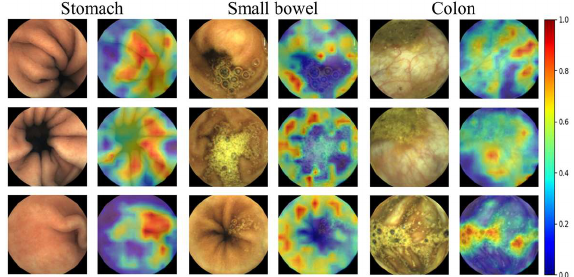
Figure 3. Relevance-CAM results from three organs. (WCE images taken by MiroCam MC1200 and processed by MiroView 4.0—http://www.intromedic.com/eng/main, accessed on 31st, July, 2022). The jet color maps show class activation maps in which the reddish and bluish colors refers to 1 and 0, respectively.